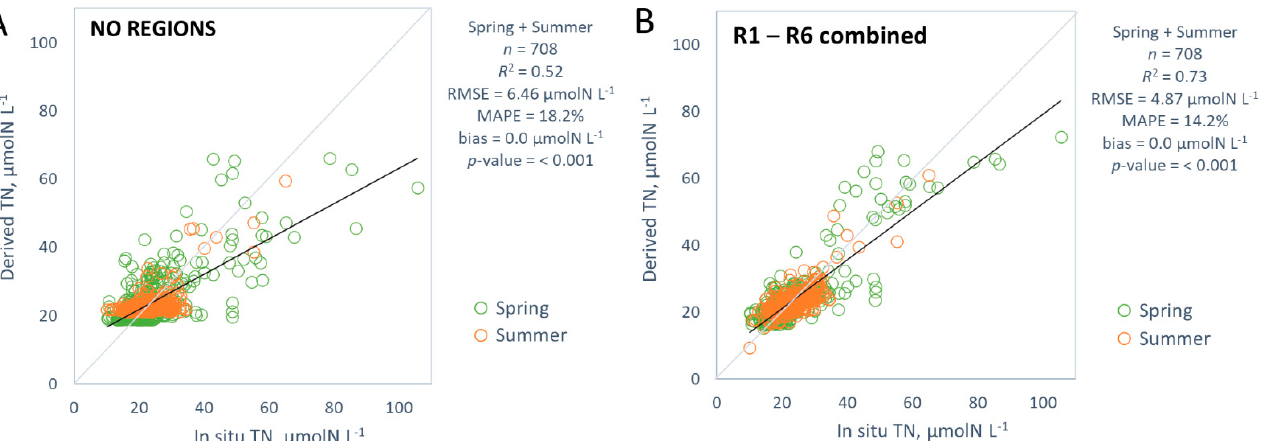
RMSE from 6.5 to 4.9 µ molN L − 1 , respectively (Figure 2).